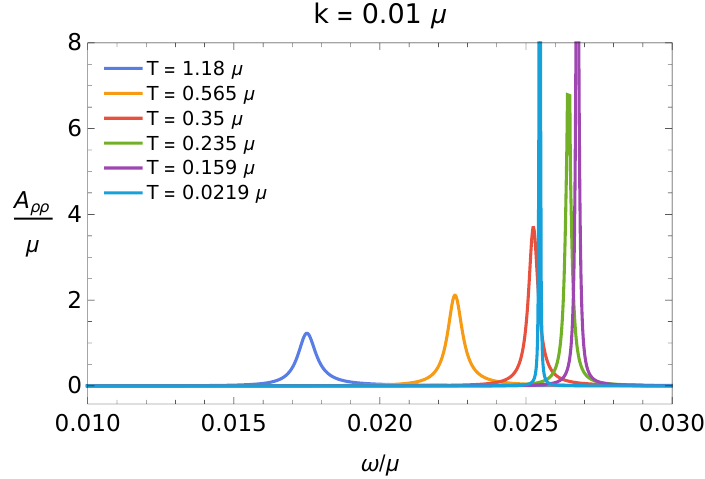
Figure 8. Temperature dependence of the plasmon mode for j k j =(cid:22) = 0 : 01 and (cid:11) 2 = 2 = 1 = 10. We see that the peaks become less pronounced as we raise the temperature due to the e(cid:11)ect of temperature (cid:13)uctuations. Moreover, for high temperatures, the position of the plasmon mode shifts towards the position of the sound mode in the neutral system, as temperature (cid:13)uctuations start dominating over the Coulomb interaction. As we lower the temperature we see that the plasma frequency reaches a maximum at T=(cid:22) = 1 = 2 (cid:25) (purple), before moving to lower values as the temperature is decreased